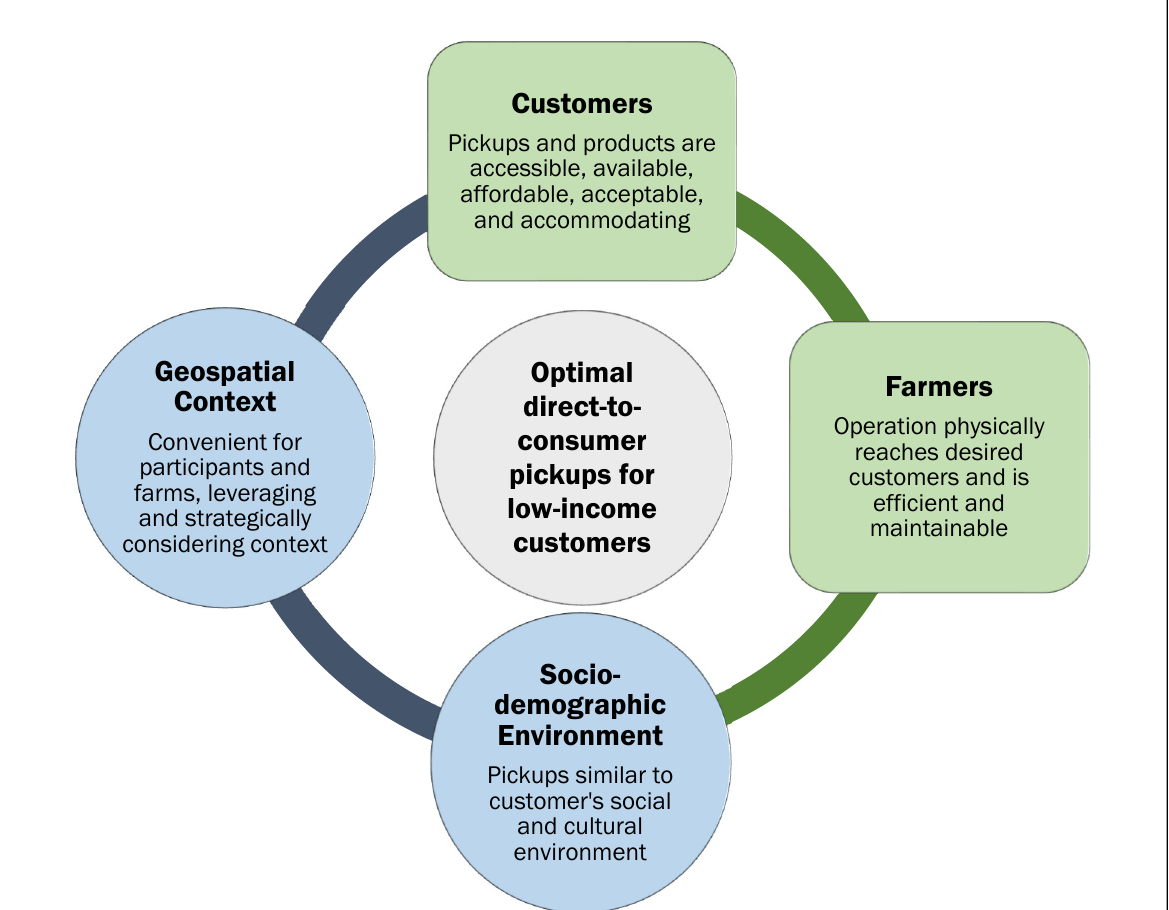
Figure 1. A Conceptual Model of Our Analytic Approach for Determining the Optimal Direct-to-Consumer Operation Locations for Farmers and Low-Income Customers (the Actors [Participant in a Process]; Green Squares) with Consideration of Spatial Factors (Influencers [the Environmental Context that Influences the Actors]; Blue